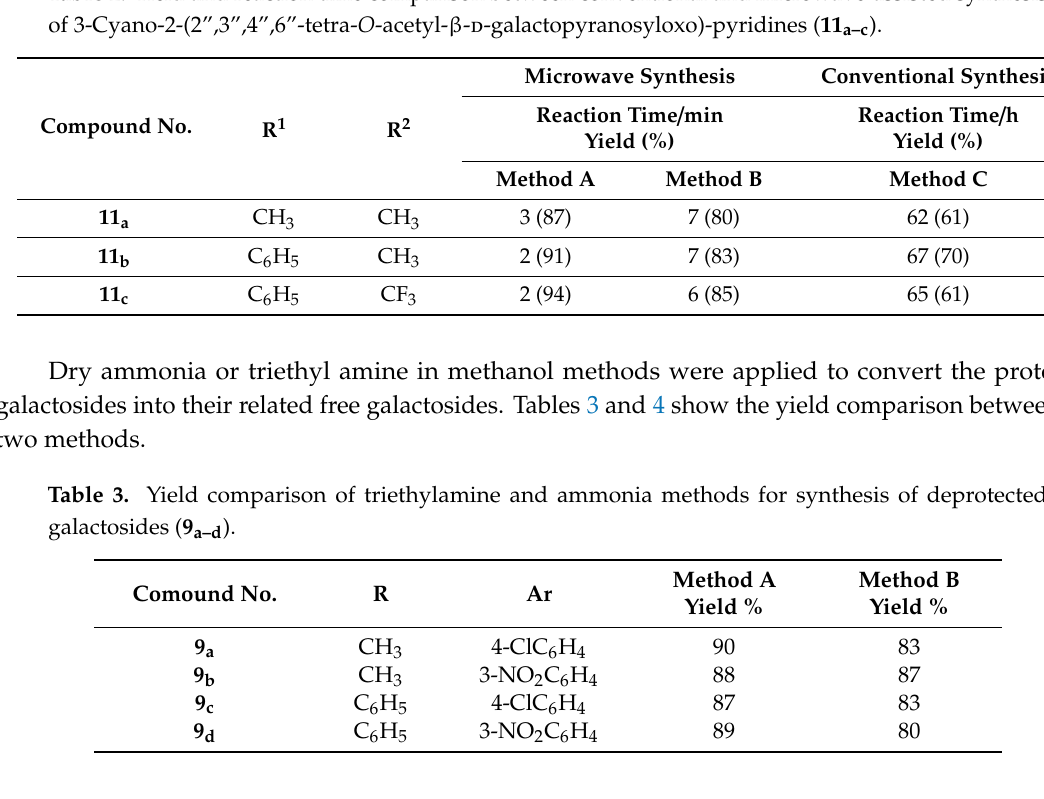
Table 2. Yield and reaction time comparison between conventional and microwave-assisted synthesis of 3-Cyano-2-(2 ″ ,3 ″ ,4 ″ ,6 ″ -tetra- O -acetyl- β - D -galactopyranosyloxo)-pyridines ( 11 a–c ).